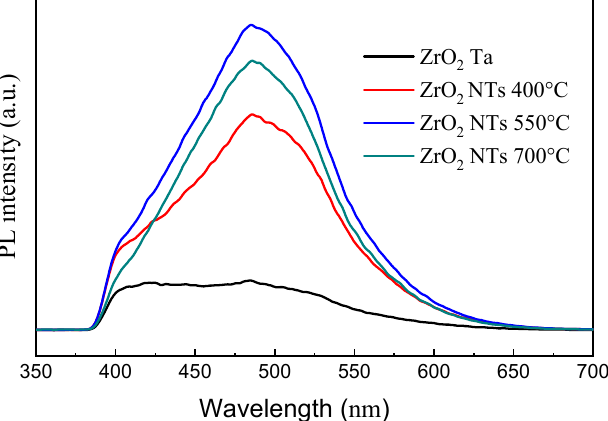
Figure 6. Photoluminescence spectra of unannealed and annealed ZrO 2 NTs.